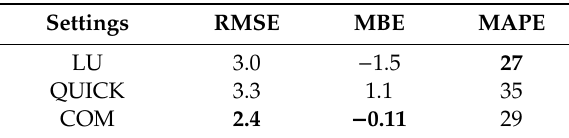
Table 8. Model root mean square error (RMSE), mean bias error (MBE), and mean absolute percent error (MAPE) for wind speeds at all locations at all sites. Positive MBE indicates model over-prediction. Bold font indicates the lowest error at each location.